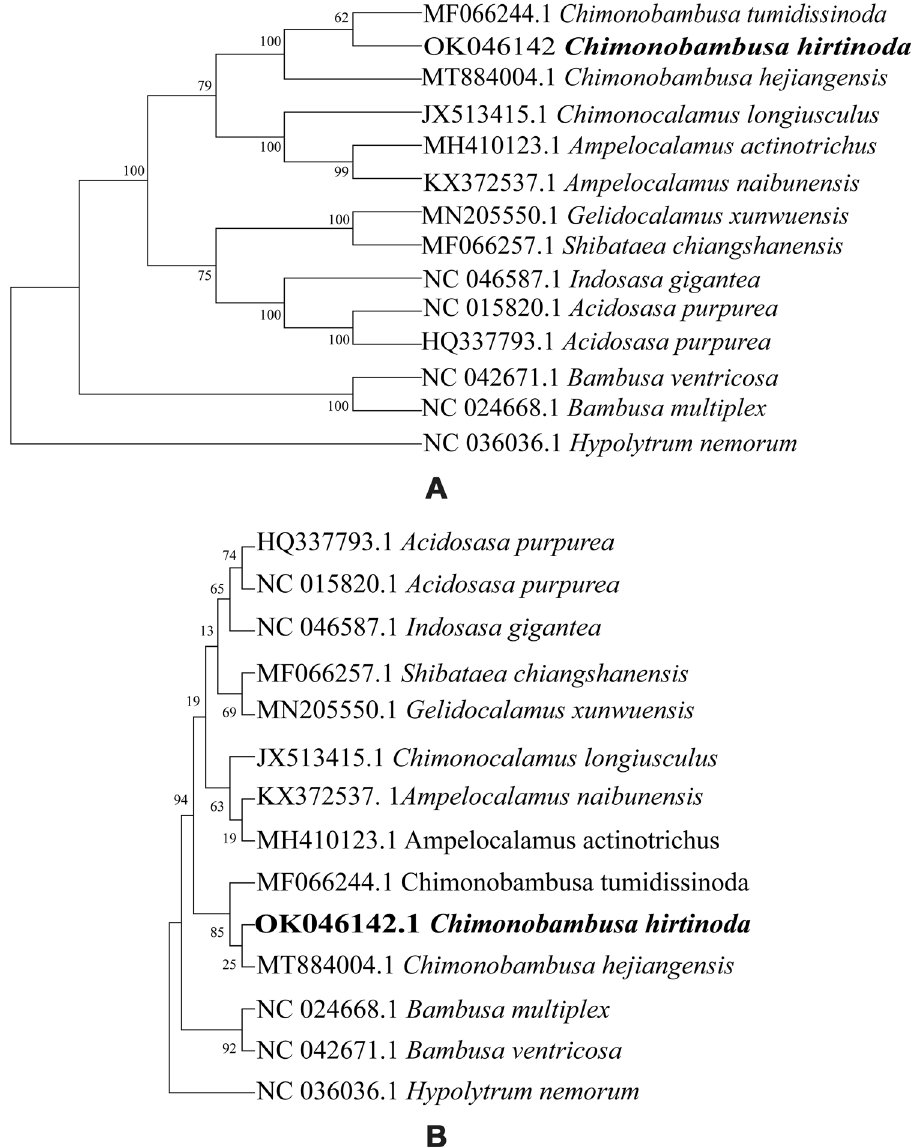
Figure 9. Maximum likelihood phylogenetic tree based on the complete chloroplast genomes ( A ) and matK gene ( B